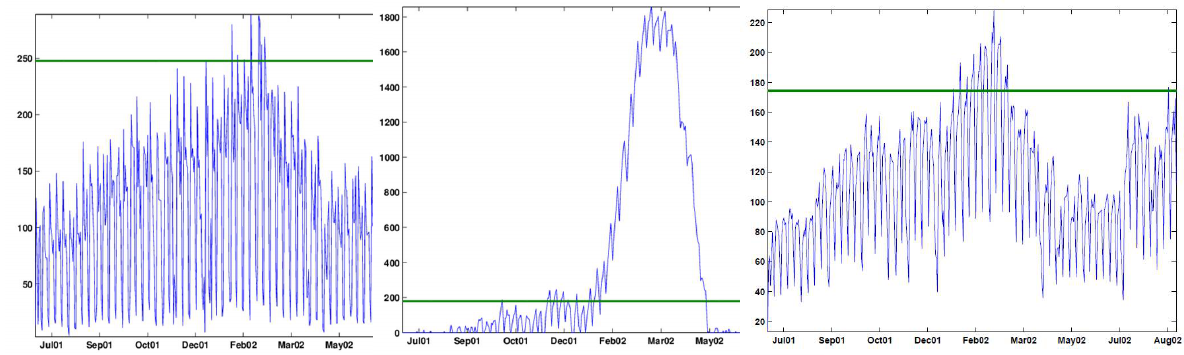
Figure 7. Shewhart x-chart ( left ), Cumulative Sum (CuSum) ( center ) and Exponentially Weighted Moving Average (EWMA) chart ( right ) applied to raw